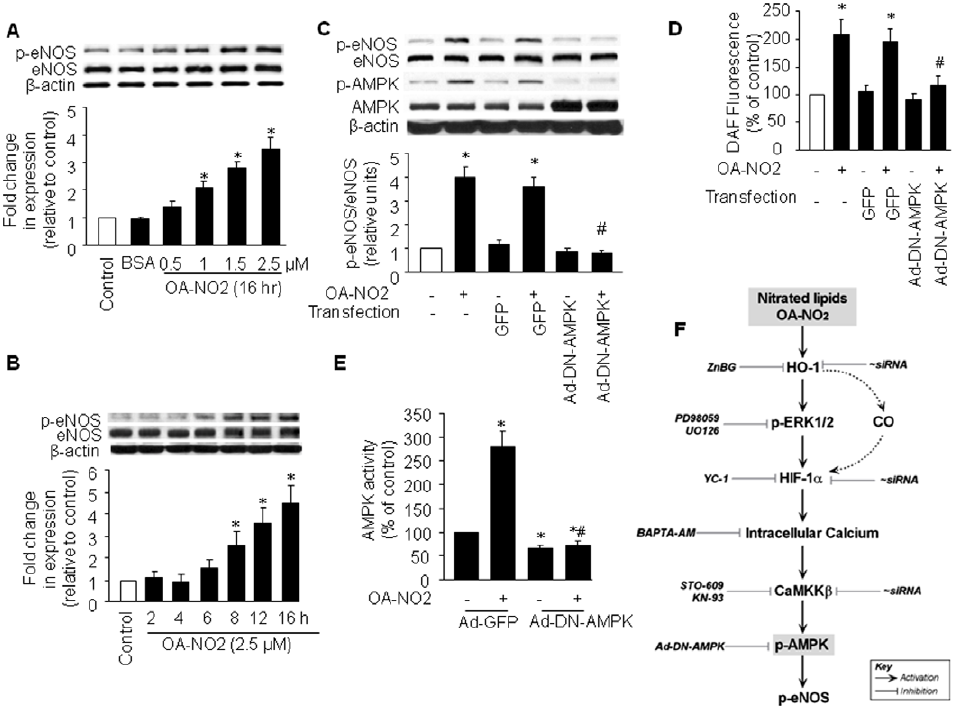
Figure 7. AMPK mediates OA-NO 2 -induced eNOS phosphorylation and NO production in BAECs. BAECs were treated with ( A ) different concentrations of OA-NO 2 for 16 h or ( B ) 2.5 m mol/L OA-NO 2 for the indicated times. Lysates were analyzed by western blot for the indicated proteins. The blot is representative of three blots obtained from three separate experiments. C ) Western blot of phosphorylated AMPK and eNOS in OA-NO 2 - stimulated BAECs infected with Ad-DN-AMPK (MOI=50). Non-infected cells or cells infected with Ad-GFP served as controls. For A–C , the corresponding densitometric analyses are shown. * p , 0.05 vs. control; # p , 0.05 vs. GFP with OA-NO 2 -treated group. D ) NO release by OA-NO 2 -stimulated BAECs infected with Ad-DN-AMPK (MOI=50) or Ad-GFP (control). * p , 0.05 vs. non-transfected, no OA-NO 2 group; # p , 0.05 vs. OA-NO 2 -treated, Ad-GFP group. E ) AMPK activity corresponding to C and D above.* p , 0.05 vs. no OA-NO 2 treatment, Ad-GFP group; # p , 0.05 vs. OA-NO 2 -treated, Ad-GFP group. F ) The proposed signaling pathway involved in AMPK/eNOS activation in response to OA-NO2 treatment in endothelial cells.